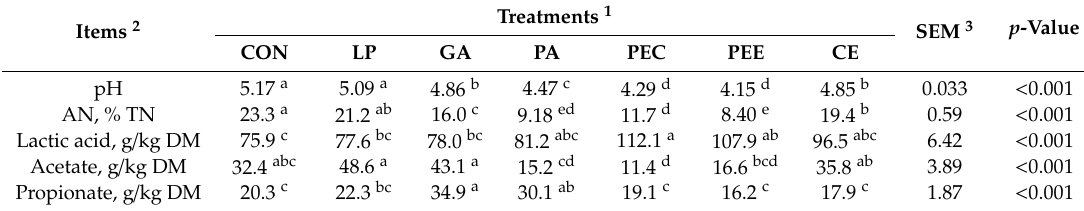
Table 1. Fermentation characteristics of alfalfa silage prepared with di ff erent additives. Items